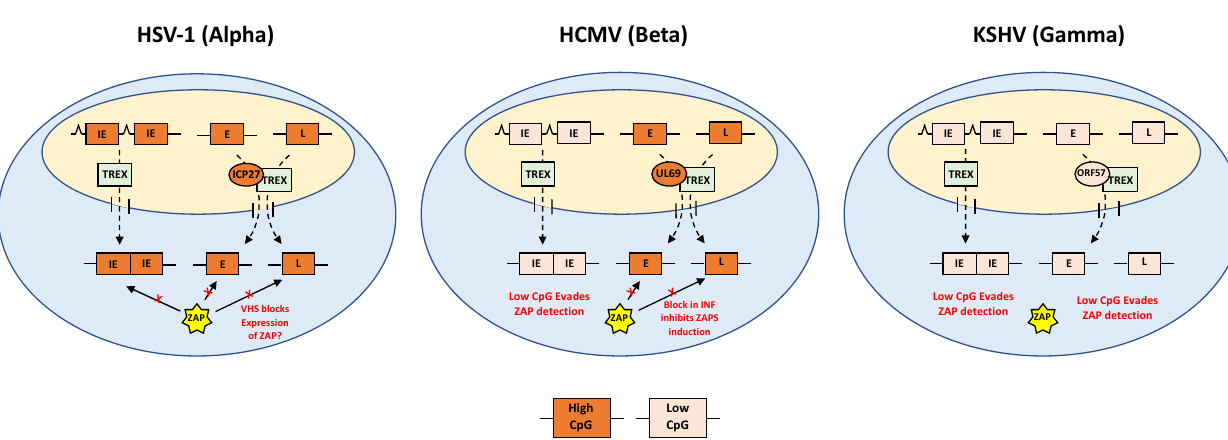
Figure 3. Divergent models of ZAP evasion by herpesvirus subfamilies. Uniformly high CpG frequencies throughout the HSV-1 genome suggests minimal evolutionary pressure from the antiviral activity of ZAP, possibly due to host shut-off blocking ZAP expression. Increased CpG levels would be predicted to increase expression efficiency, while ICP27 may preferentially bind to viral transcripts with high CpG frequencies. HCMV (betaherpesvirus) has suppressed CpG levels in the major immediate early gene, IE1 enabling ZAP evasion. Higher CpG frequencies in early and late genes would be predicted to increase expression efficiency while blocking IFN signalling would subvert ZAP targeting. Like ICP27, UL69 would be predicted to preferentially bind transcripts with high CpG frequencies. Low CpG frequencies throughout the KSHV genome would enable evasion of ZAP while making efficient expression of unspliced viral transcripts highly dependent on ORF57 binding. In all cases, splicing of immediate early genes would enable expression independent of ICP27 homologues.